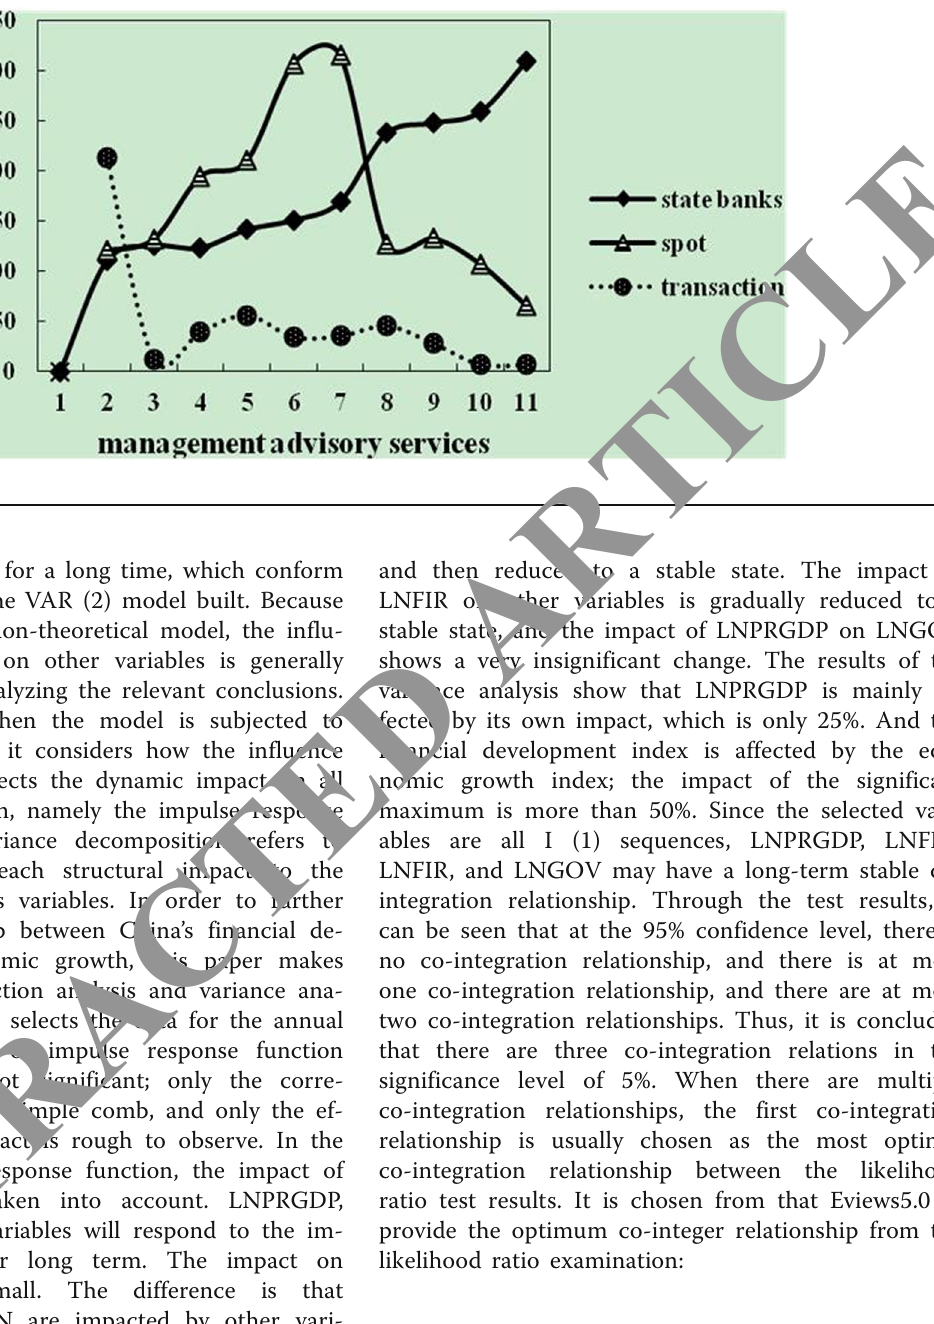
Table 4 The test results of the VAR model